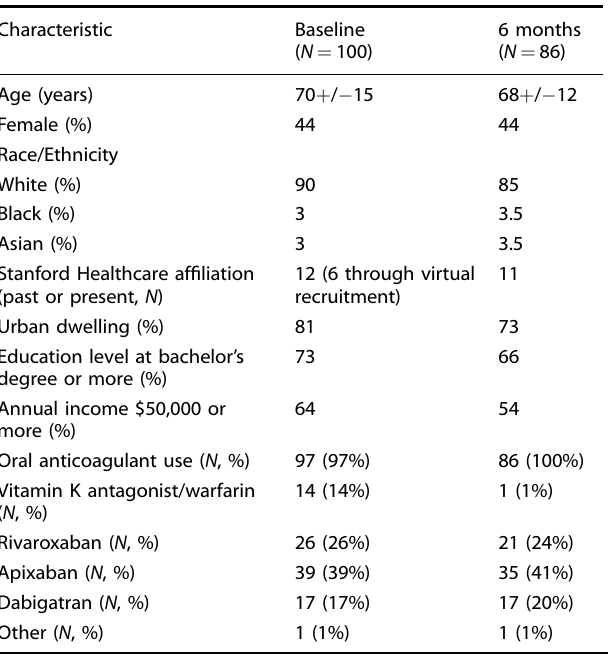
Table 1. Baseline patient characteristics.